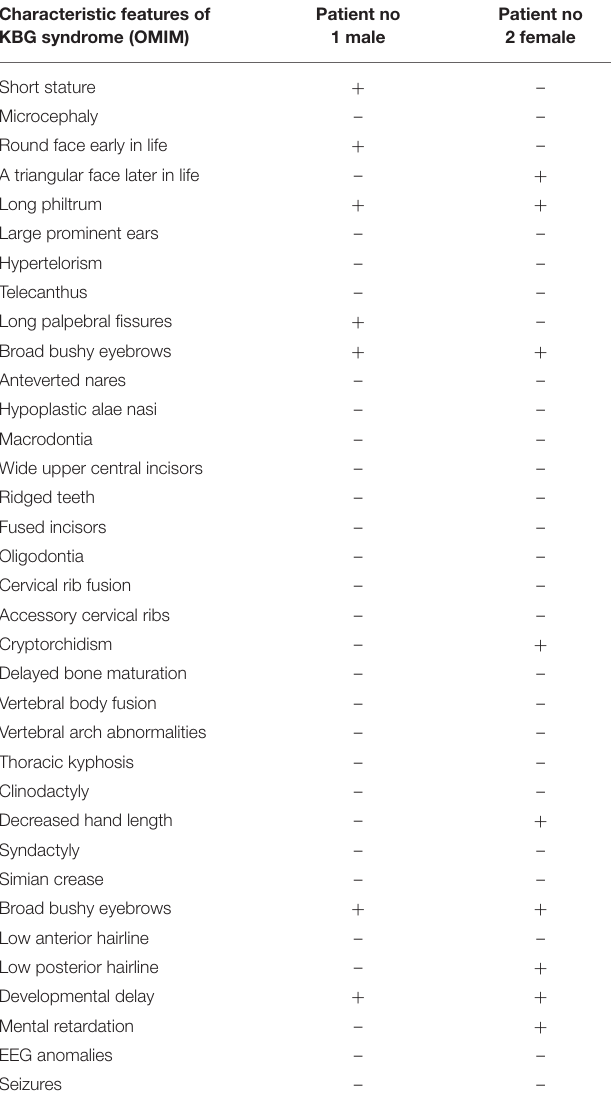
TABLE 1 | Characteristic features of KBG syndrome, which are listed in OMIM, and features of our patients. Characteristic features of KBG syndrome